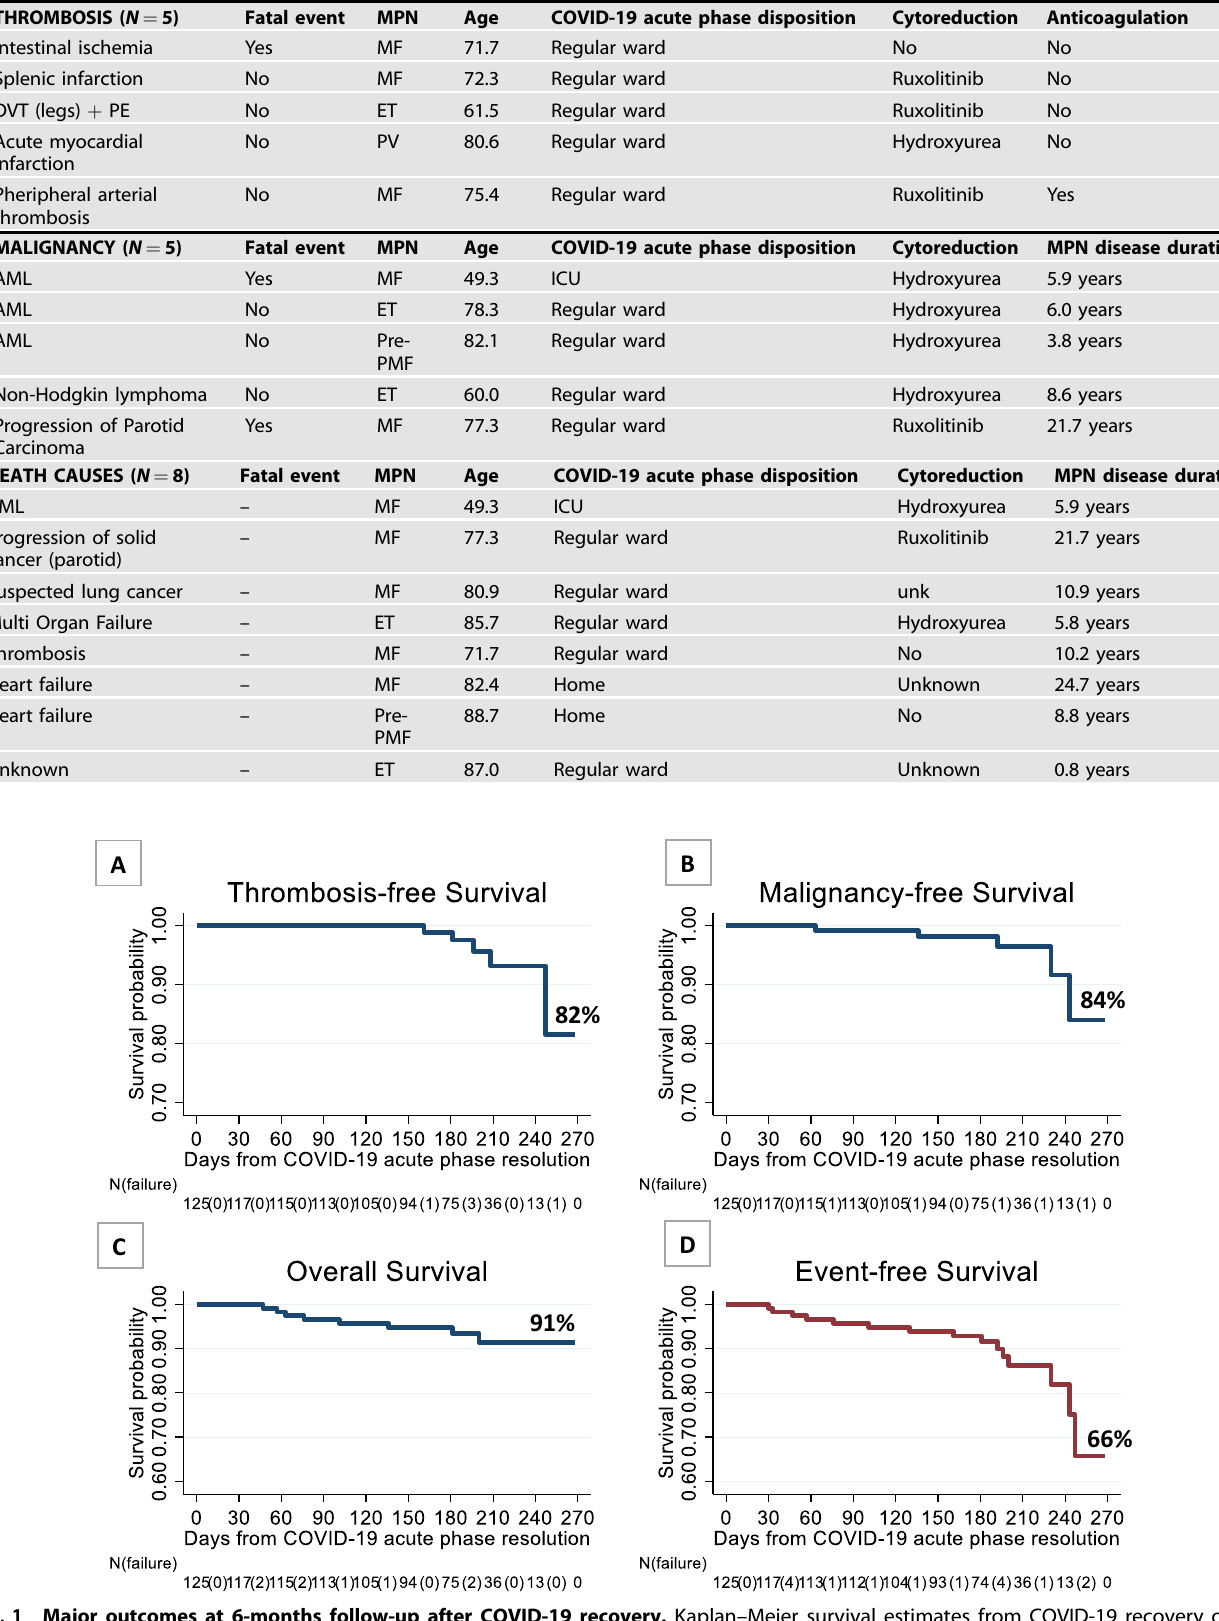
Table 1. Main characteristics of patients with major outcomes at the 6-month follow-up after COVID-19 recovery. THROMBOSIS ( N = 5)